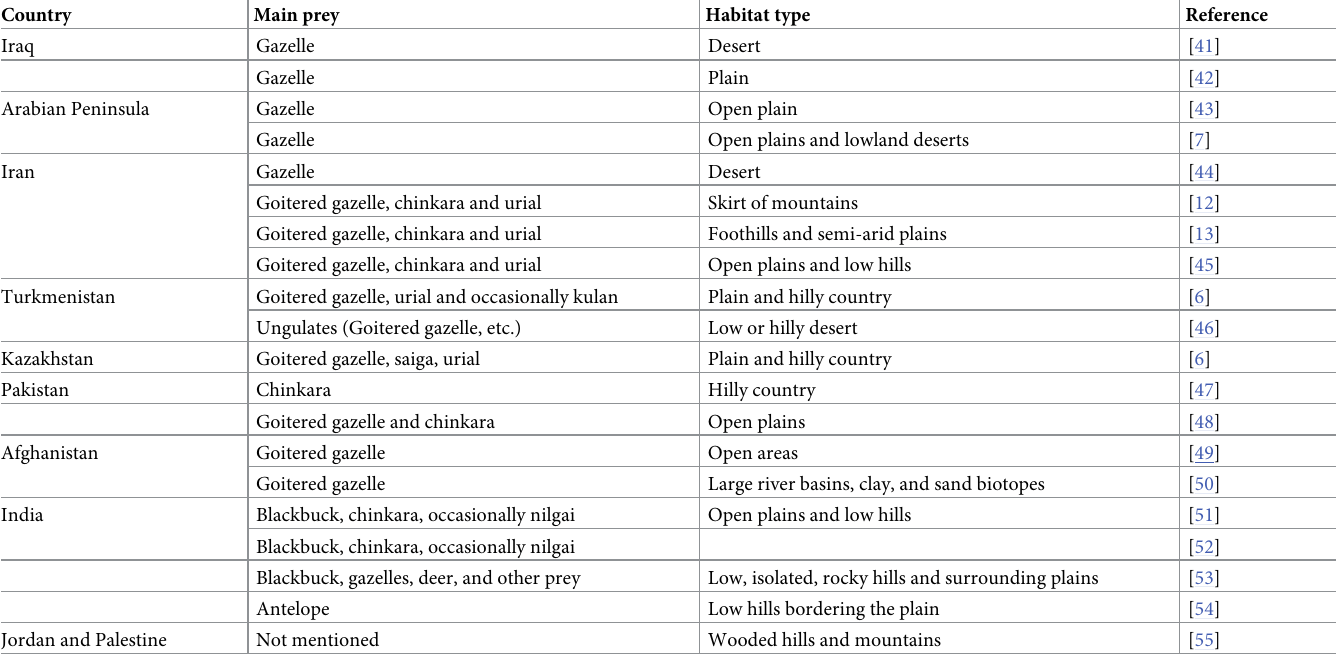
Table 1. The zoological records in historic range of cheetahs in Asia (1890–1980) which included data on prey and habitat selection of cheetahs. Latin names of prey species are as the following: Goitered gazelle ( Gazella subgutturosa ), Saiga ( Saiga tatarica ), Urial ( Ovis vignei ), Chinkara ( Gazella bennettii ), kulan ( Equus hemionus ),